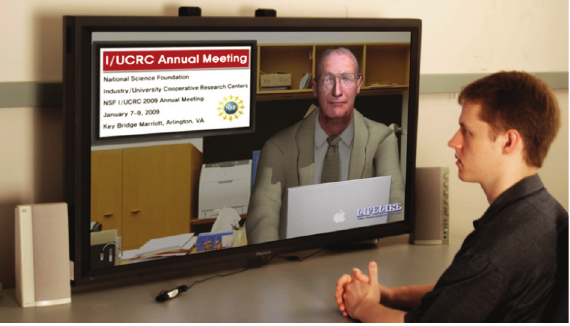
Figure 5. LifeLike Responsive Avatar Framework Displayed on a 50-in. Screen for a Life-Sized